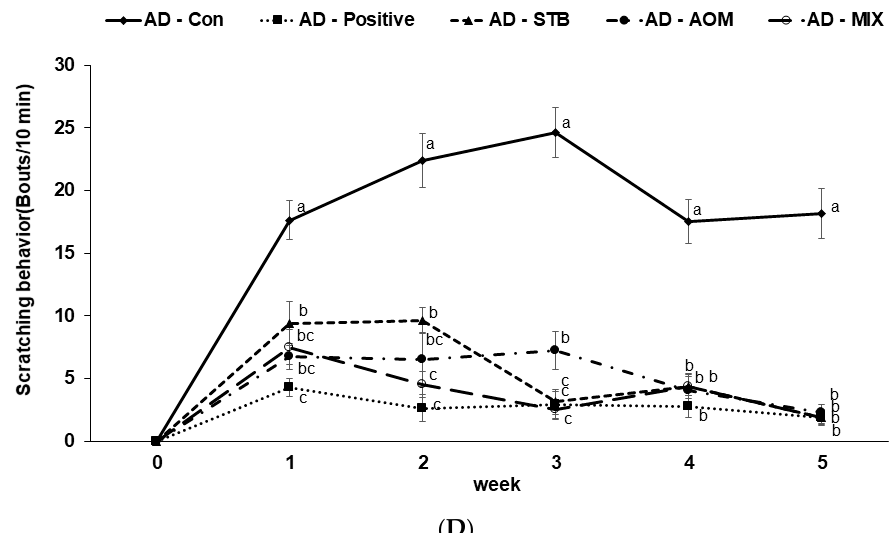
Figure 2. The severity of clinical atopic dermatitis symptoms. ( A ) Changes in atopic dermatitis symptoms at the dorsal skin lesion from week 0 to week 5. ( B ) The severity of each clinical atopic dermatitis symptom at the 5th week ( C ) Weekly scores of an average of 5 clinical atopic dermatitis symptoms from week 0 to week 5. ( D ) Changes in scratching behavior scores from week 0 to week 5. a,b,c Means with different superscripts were significantly different among the groups in each parameter by Tukey test at p < 0.05.